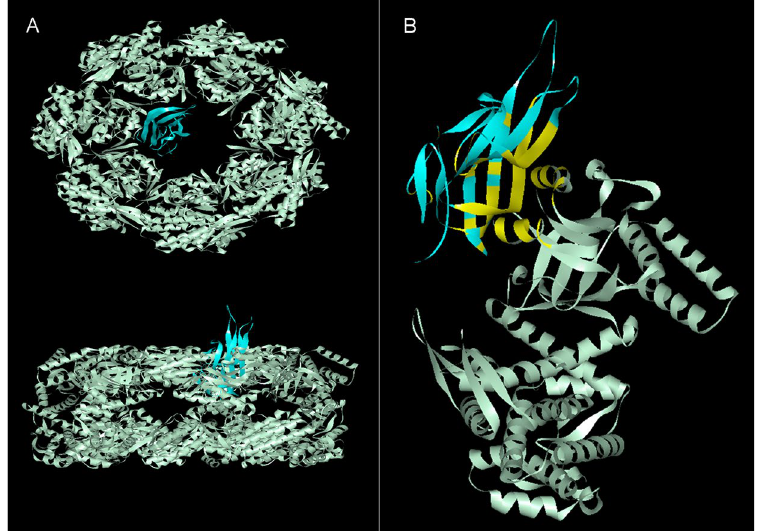
Figure 2. Molecular docking of GroEL (light gray) and TRAIL (blue). ( A ) Top view (top) and side view (bottom) of the docked complex. ( B ) The binding interface (yellow) of the GroEL subunit and single-chain